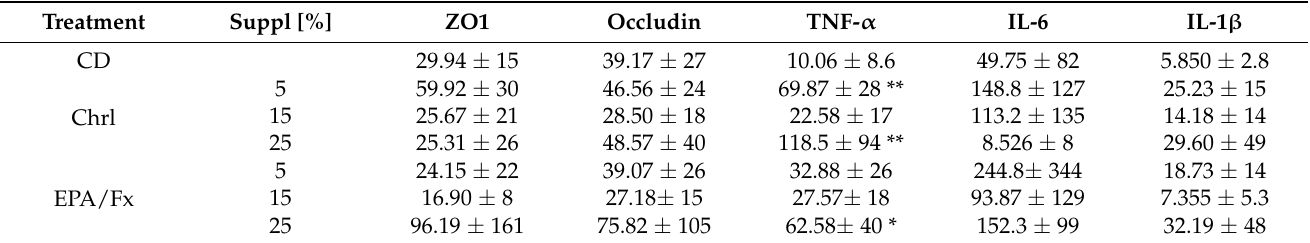
Table 3. Intestinal and inflammatory markers measured in the ileum